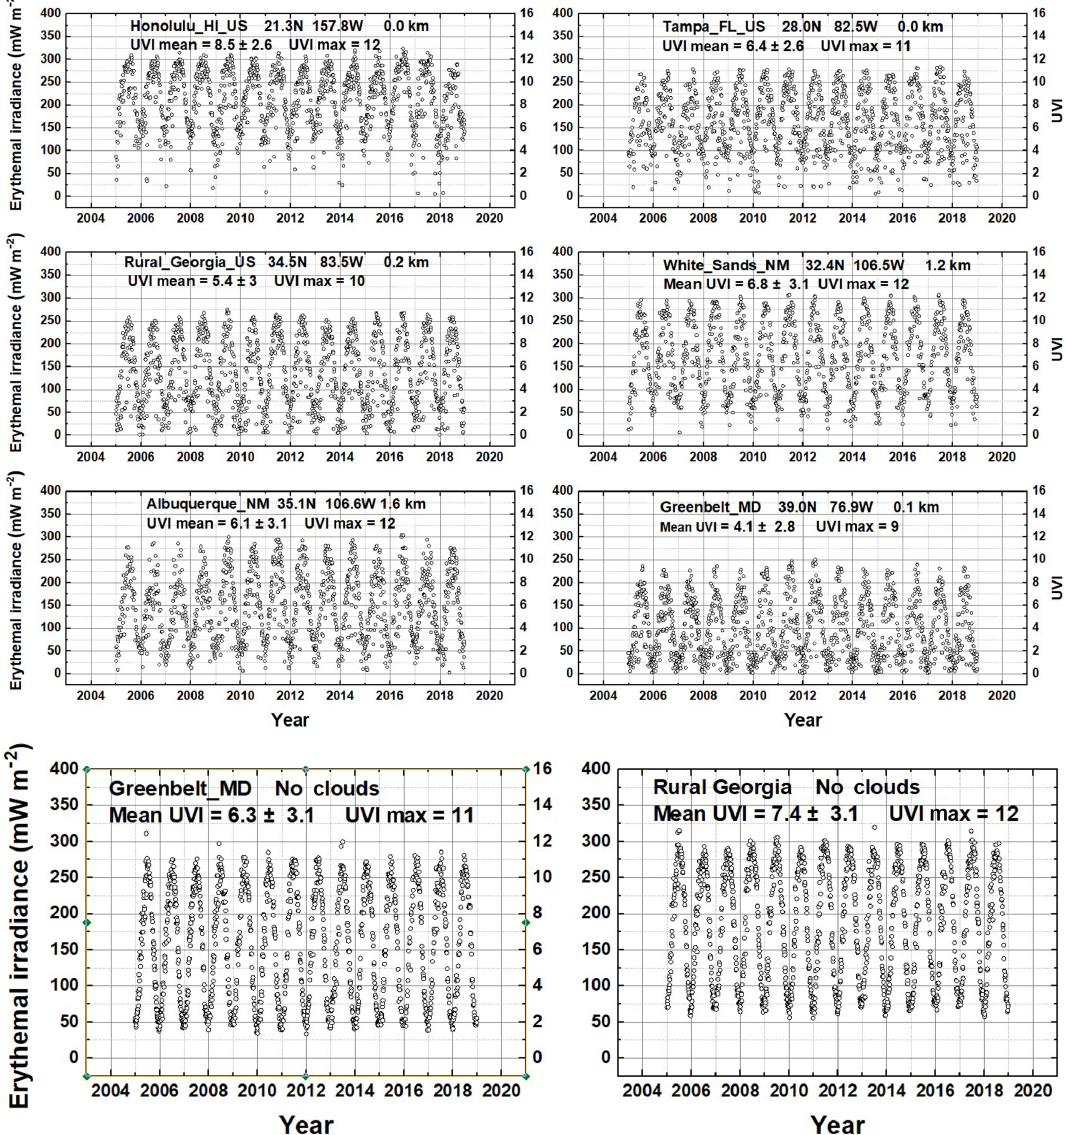
Figure 3. (a) Erythemal irradiance E(θ,ϕ,z,t) at six selected sites from Table A1 distributed within the United States. Listed are the 14-year UVI average maximum and average values (UVI = E/ 25) (see Table 3). Mean and maximum values are 14-year averages. (b) Two sites from Fig. 1a, Greenbelt, Maryland, and Rural Georgia, with the effect of clouds and aerosols removed (i.e., T = 1, τ A = 0).